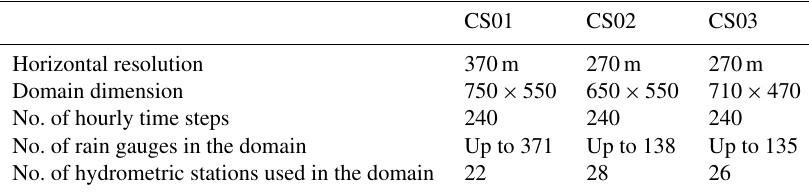
Table 4. CHyM domain set-up for the analysed case studies. Please note that the rain gauge data may not all be available during the entire event, due to interruption of electric